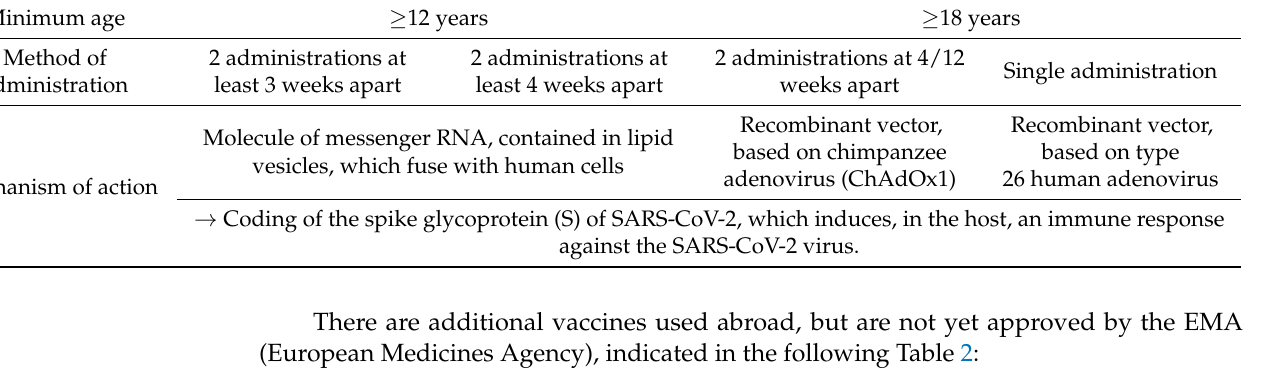
Table 1. Main characteristics of the SARS-CoV-2 vaccines currently on the market in Italy [4–7]. Comirnaty Spikevax (Moderna) (BioNTech/Pfizer)